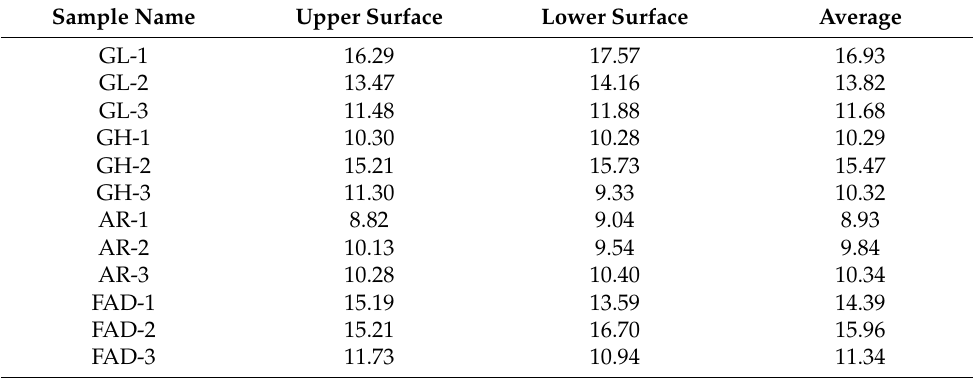
Table 3. Joint roughness coefficient values of natural fracture